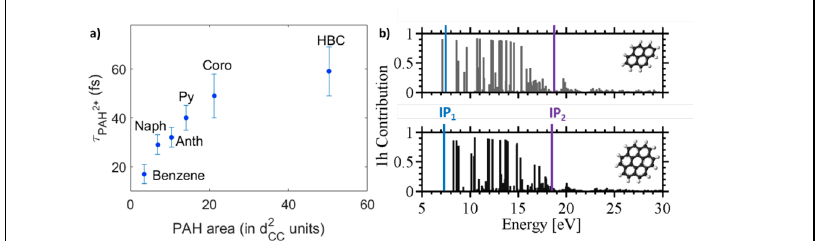
Fig. 2. a) Dication decay constant as a function of the PAH area (given in units of the distance between two adjacent carbon atoms, d CC ); Benzene (C6H6) is taken from [8]; b) Computed